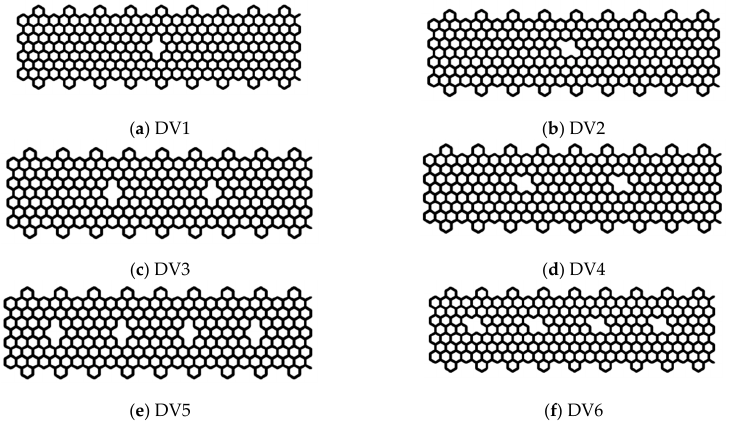
Figure 12. Geometry of CGNR with single and multiple DV defects.